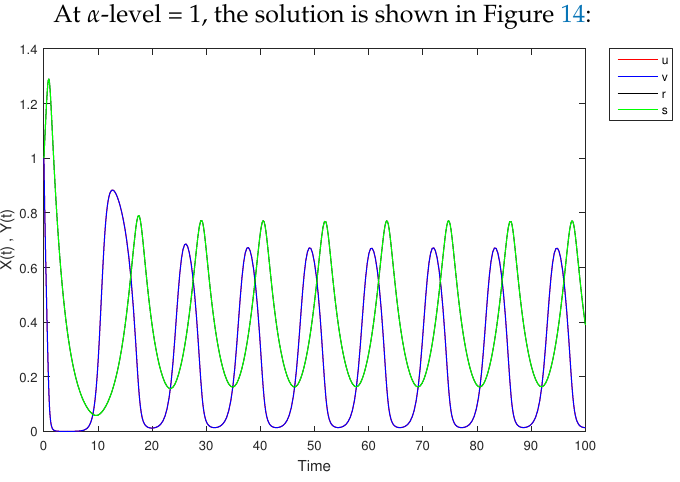
Figure 14. The solution of (7) at α